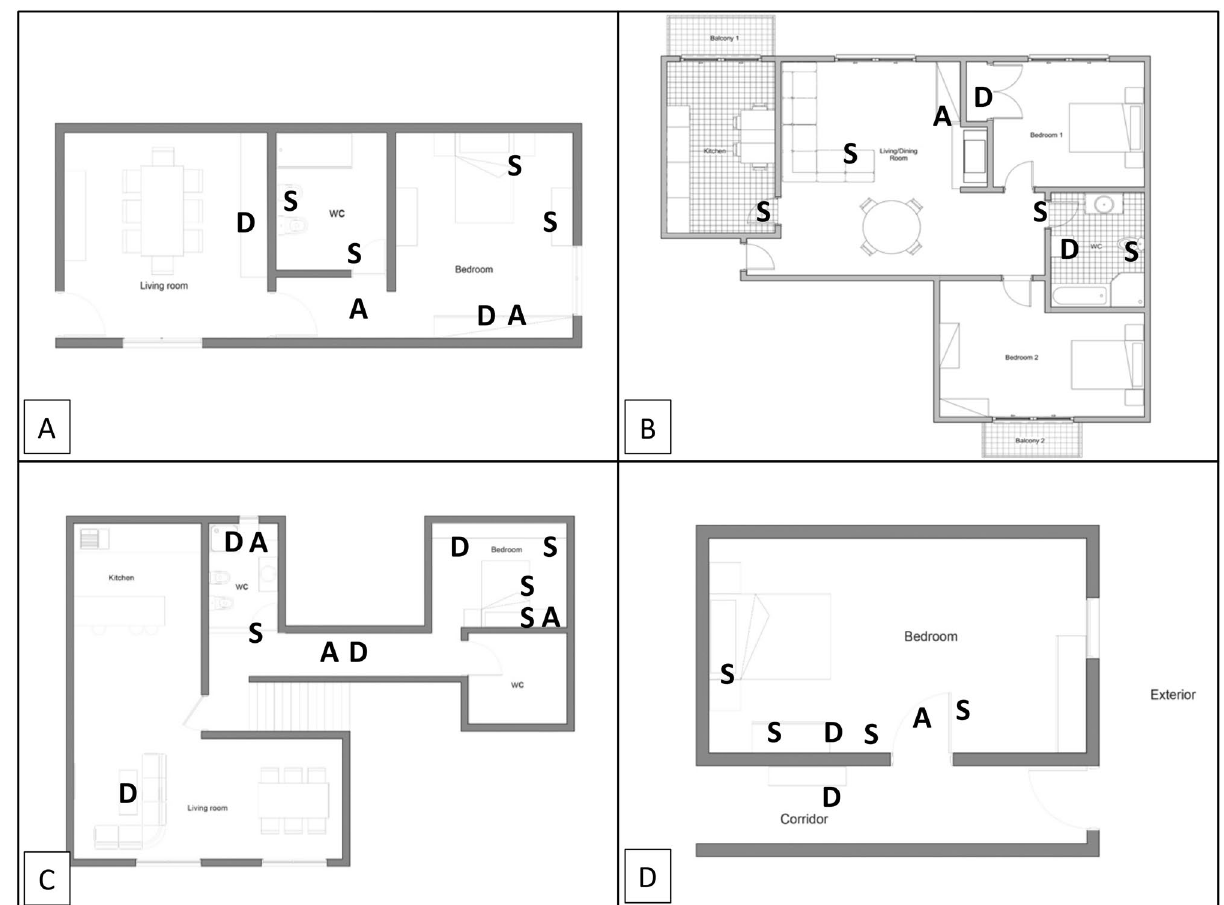
Figure 3. Schematic top view illustration of the representative house areas and sampling sites. The spaces where sampling occurred are designated accordingly (Houses A, B, C and D). A air samples, S surface samples, D deposition